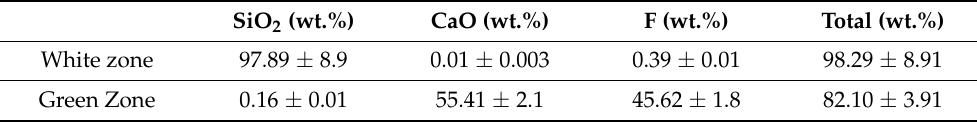
Table 1. EPMA results of the white and green zones of the sample. SiO 2 (wt.%) CaO (wt.%) F (wt.%) Total (wt.%)